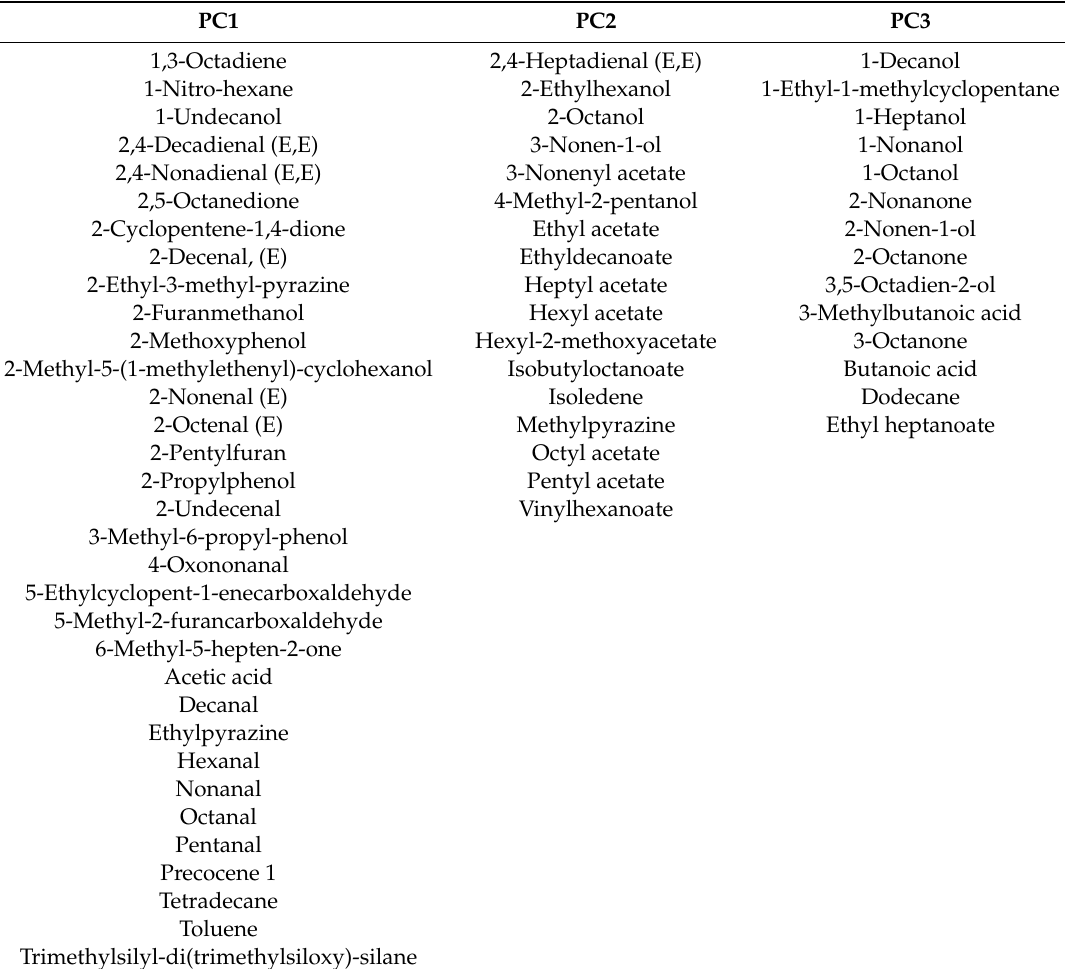
Table 2. Volatile organic compounds identified through solid-phase microextraction GC coupled to the three principal components (PC) obtained after principle component analysis of all data. PC1